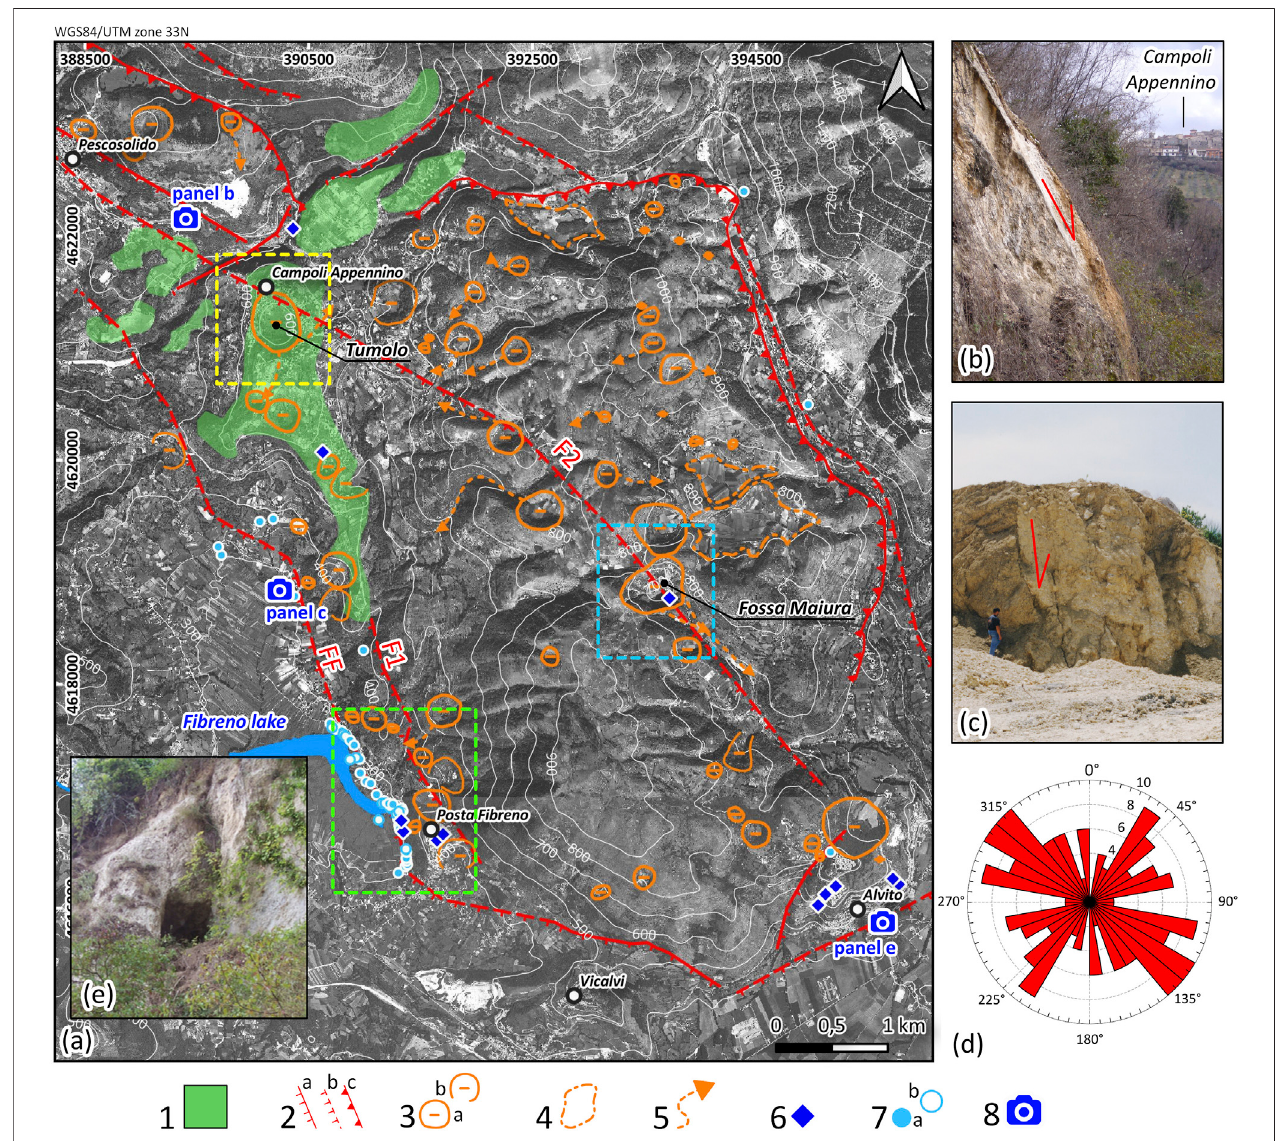
FIGURE 4 | Results of the geomorphological analyses performed over the study area. (A) Morphological map. (B) and (C) Evidence of dissection of upper Pleistocene – Holocene deposits by the FFS normal faults (FF, F1 and F2) in panel A; (D) Bidirectional rose diagram showing the observed fracture orientations at each geostructural station (bin size 10 ° ). (E) example of a cave entrance. Key to the legend: 1) Plio-Quaternary continental conglomerates deposited approximately since 2.6 Ma(Saroliet al.,2015);2)Mainfaults:(a) normal, (b) normal inferred,(c) thrust;3)Dolines:(a) nestedcontours,(b)non-nested contours;4)polje;5) dryvalley;6) cave entrance; 7) Springs: (a) shoreline spring, (b) underwater spring; 8) Location of the pictures in panels b, c and e.